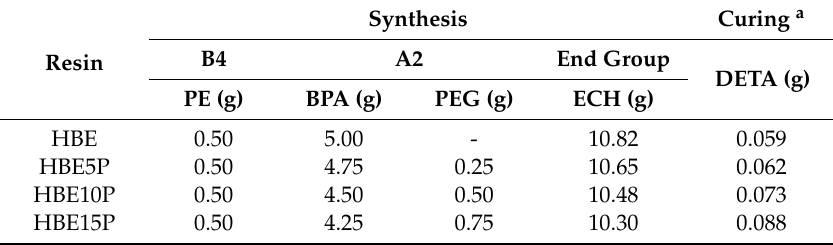
Table 1. The mixture composition for synthesis of hyperbranched epoxy resins and for curing reaction. Synthesis Curing a B4 A2 End Group Resin DETA (g) PE (g) BPA (g) PEG (g) ECH (g) HBE 0.50 5.00 - 10.82 0.059 HBE5P 0.50 4.75 0.25 10.65 HBE10P 0.50 4.50 0.50 10.48